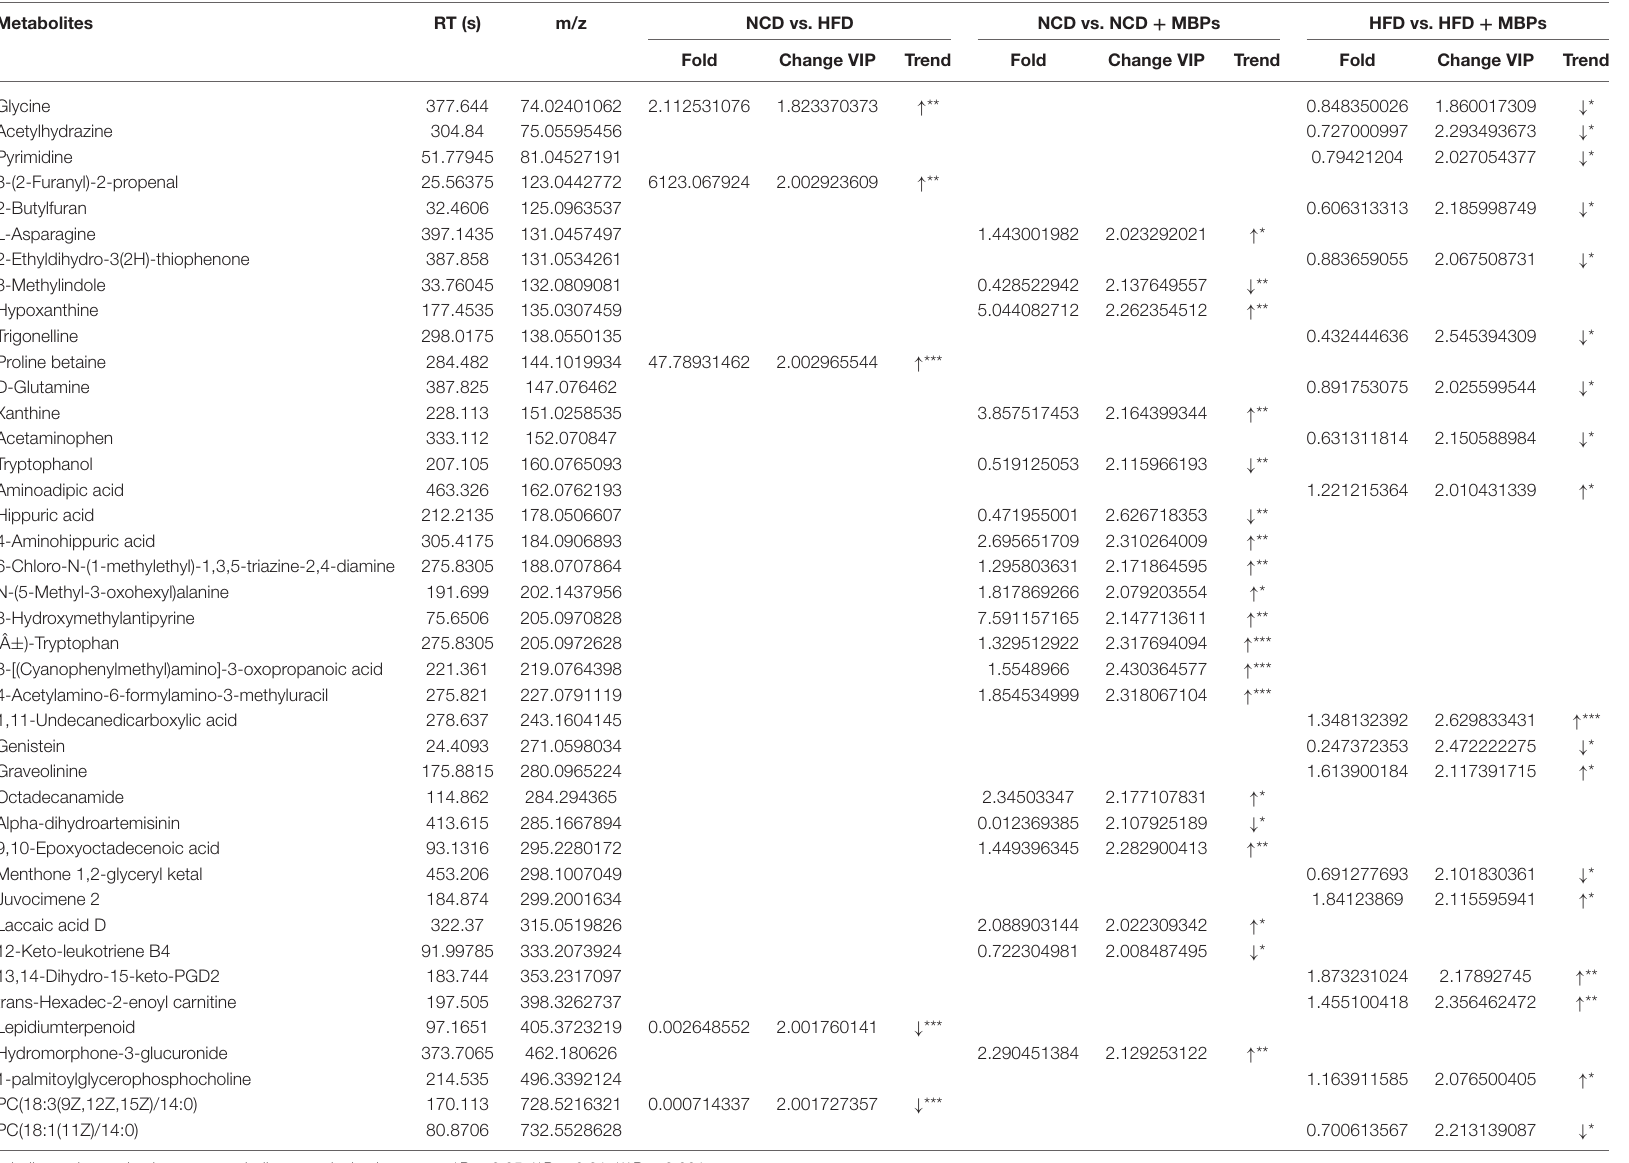
TABLE 2 | Detection of differential significant metabolites in serum